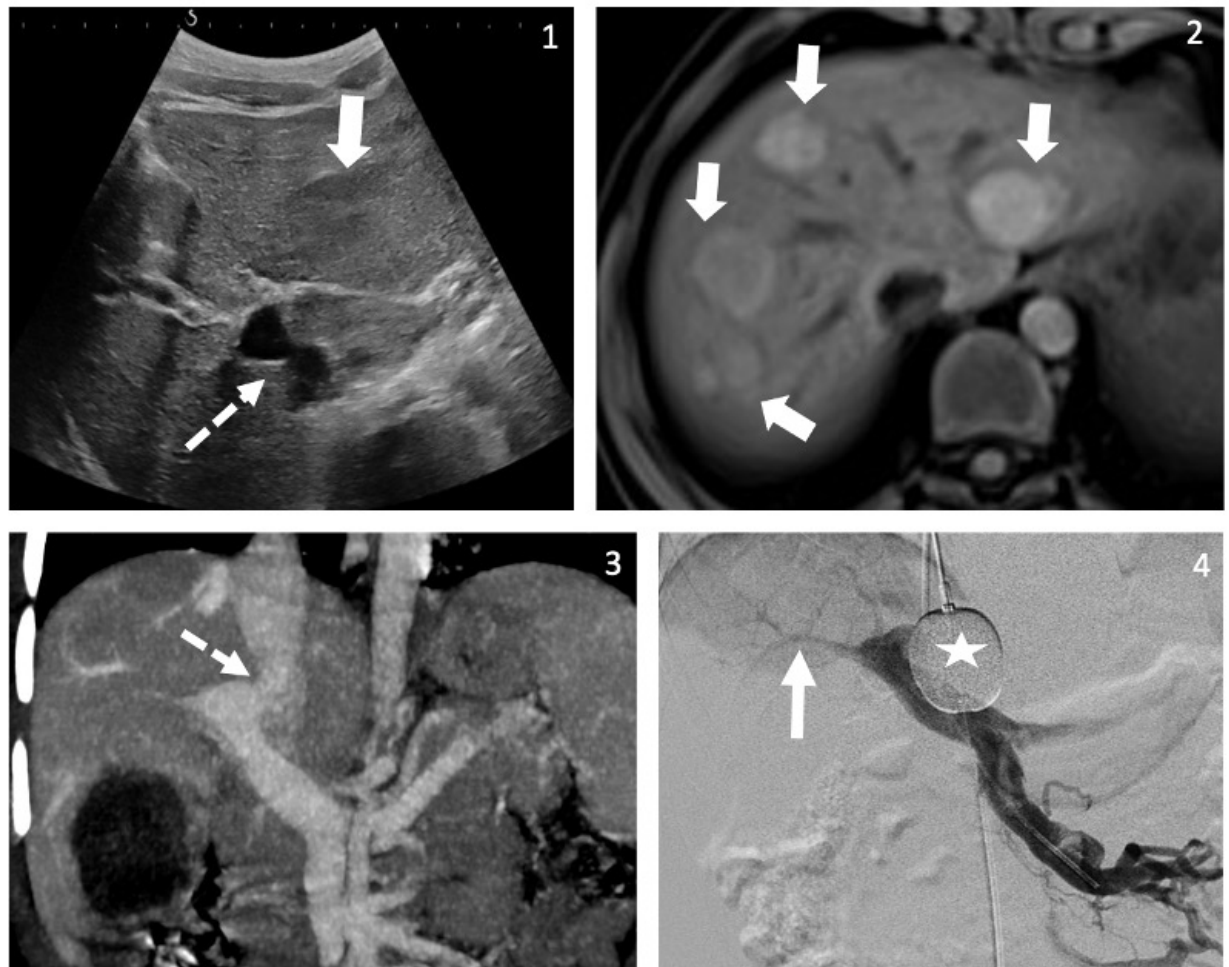
Figure 2. Case C. Aspect on imaging of the congenital porto-systemic shunt (CPSS) and the liver nodules. ( 1 ) Axial view on US B-mode at the level of the portal bifurcation shows the direct communication between the portal bifurcation and the inferior vena cava (IVC) (dotted arrow). There is a large liver tumor in the left hepatic lobe (large white arrow). ( 2 ) Axial view on MRI with contrast injection at the arterial phase shows the strong early enhancement of multiple hepatic nodules corresponding to hepatocellular proliferation. ( 3 ) Coronal view of an abdominal contrast enhanced computed tomography (CT) at the portal phase shows the direct communication between the portal bifurcation and the IVC. ( 4 ) Direct portal venography after occlusion of the CPSS with a balloon inflated in the IVC (star) shows hypoplastic right portal vein that was not visible on non-invasive imaging (plain arrow).